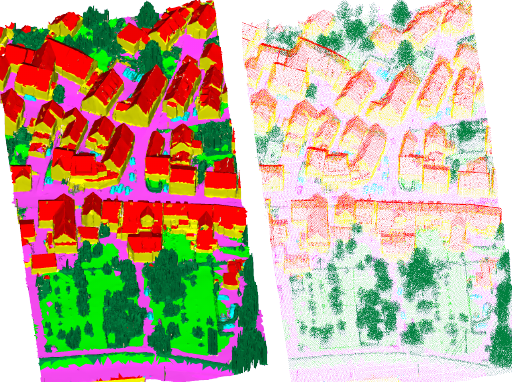
Figure 1. Predicted semantic mesh segmentation utilizing mesh-inherent and LiDAR-inherent features ( left ) and its transferred labels to the dense LiDAR point cloud ( right ; subsampled by factor 20 for visualization). The following class color code is used throughout the paper: building mass/facade (yellow), roof (red), impervious surface (magenta), green space (light green), mid and high vegetation (dark green), vehicle (cyan), chimney/antenna (orange) and clutter